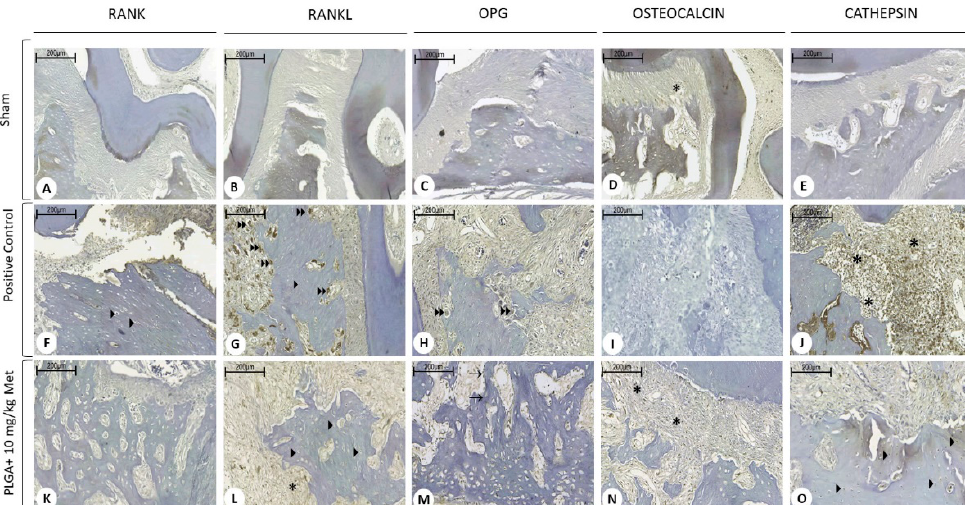
Figure 7. Photomicrographs of periodontal tissue of PD rats treated with PLGA + 10 mg/kg Met, Sham, and positive control groups, showing immunoreactivity to RANK, RANK-L, OPG, cathepsin K, and osteocalcin. Legend: ( A – E ) Saline group with discrete immunoblotting for osteocalcin. ( F – J ) Positive control group exhibiting discrete immunoblotting for RANK and OPG, intense for RANKL and cathepsin. ( K – O ) PLGA + 10 mg/kg Met group demonstrating discrete immunoblotting for RANKL, OPG, osteocalcin, and cathepsin. ∗ inflammatory cells; osteocytes; osteoclasts; → osteoblasts. Scale bar: 200×.